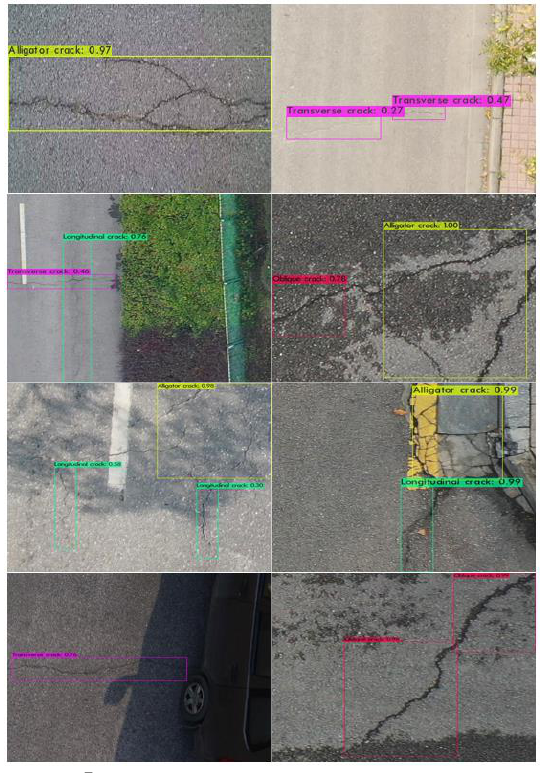
Figure 4 . The loss graph in the training process of the network.